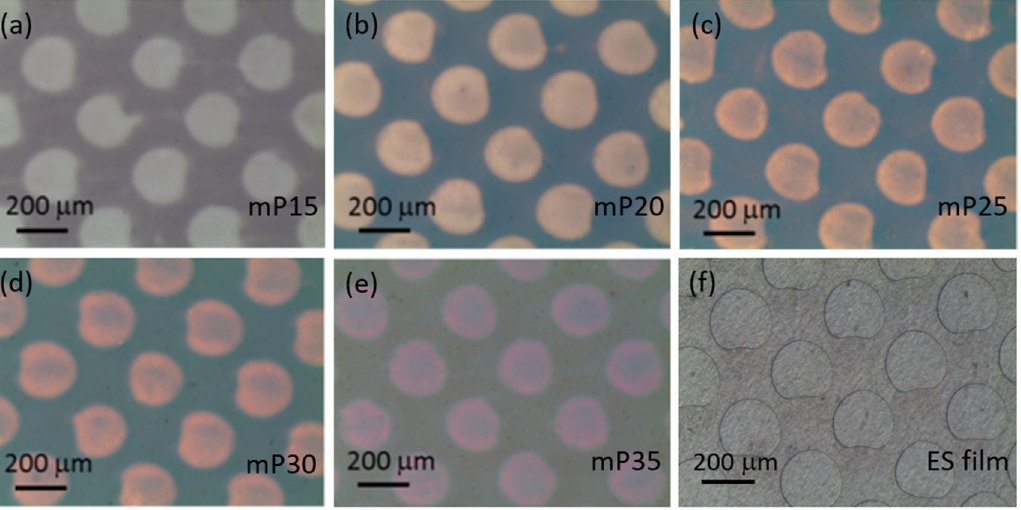
Figure 1. Optical microscope images of the mPEDOT thin films deposited using charge capacities of ( a ) 15 mC/cm 2 , ( b ) 20 mC/cm 2 , ( c ) 25 mC/cm 2 , ( d ) 30 mC/cm 2 , and ( e ) 35 mC/cm 2 . ( f ) Optical microscope image of an electrostatic film.